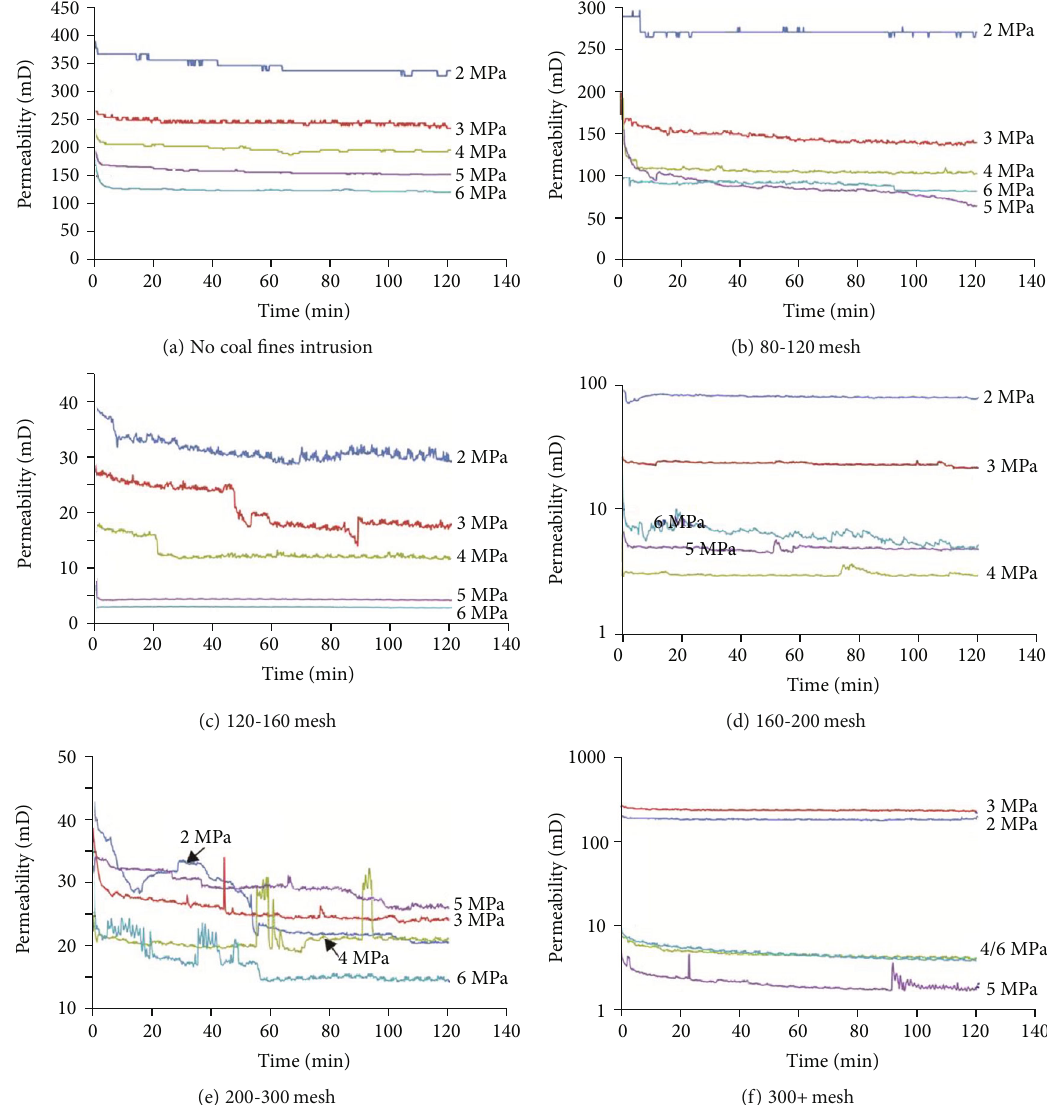
Figure 11: Permeability evolution under di ff erent con fi ning pressure ( fl ow velocity of